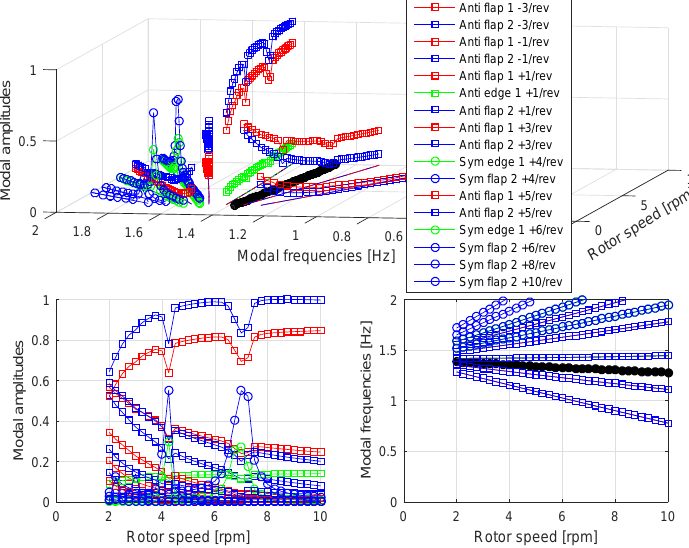
Figure 21. Harmonic modal components for the two-bladed turbine mode dominated by antisymmetric deflection of the rotor in the second flapwise DOF. Plot layout as in Fig.